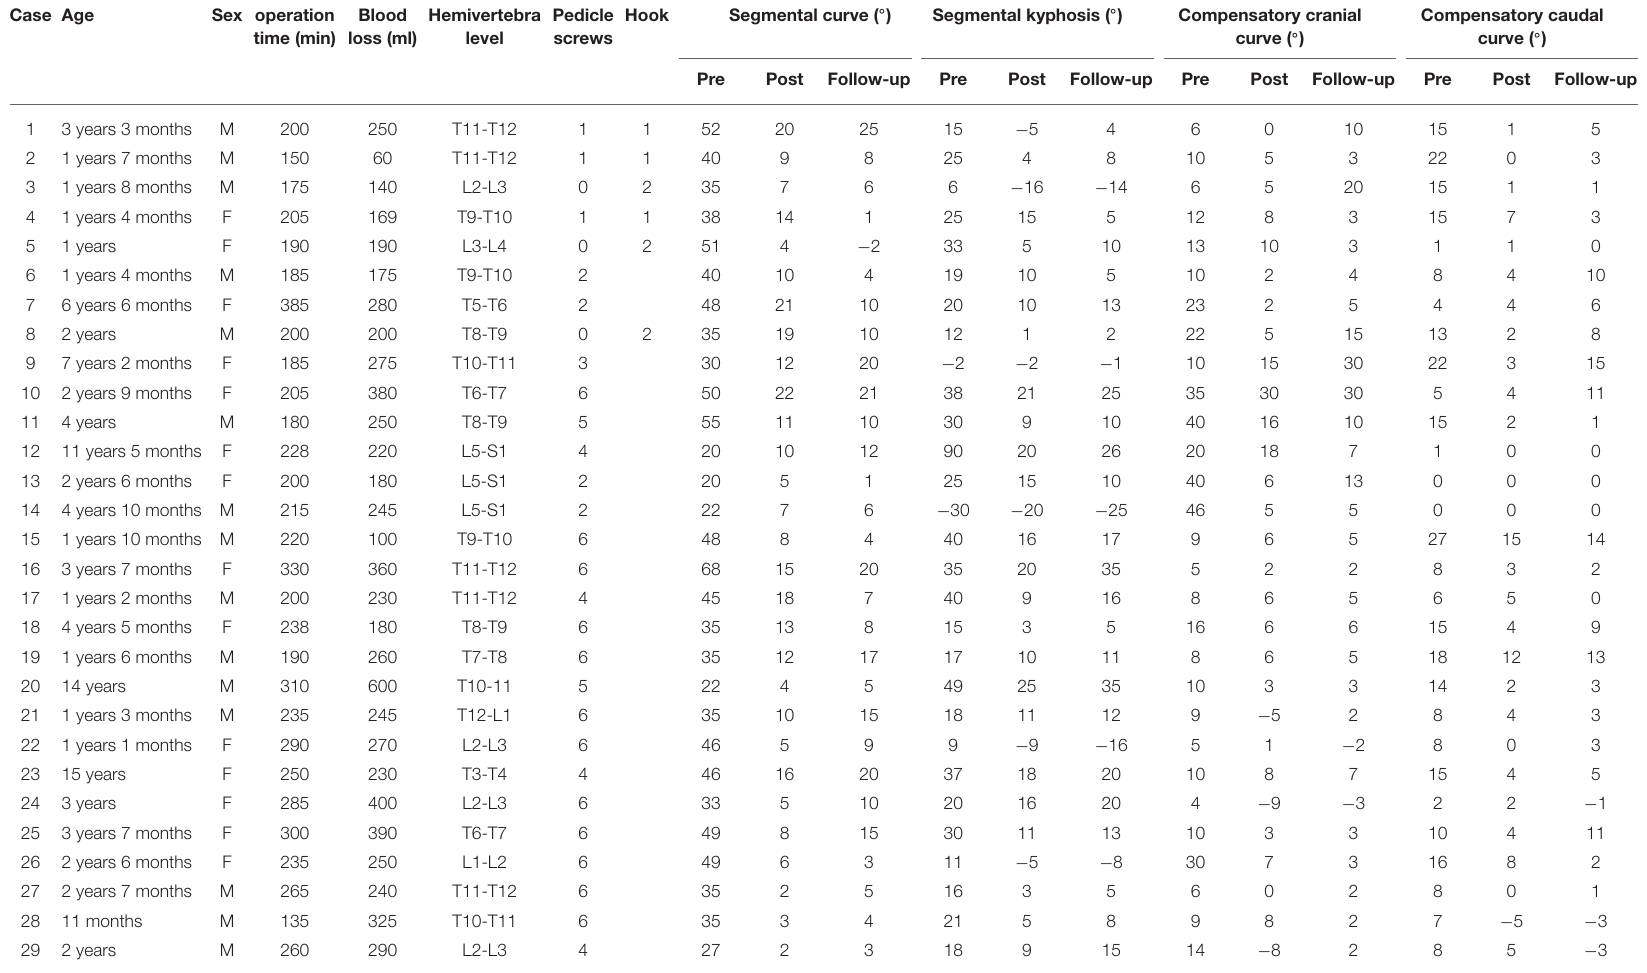
TABLE 1 | The summary on hemivertebra resection levels and follow-up results for all